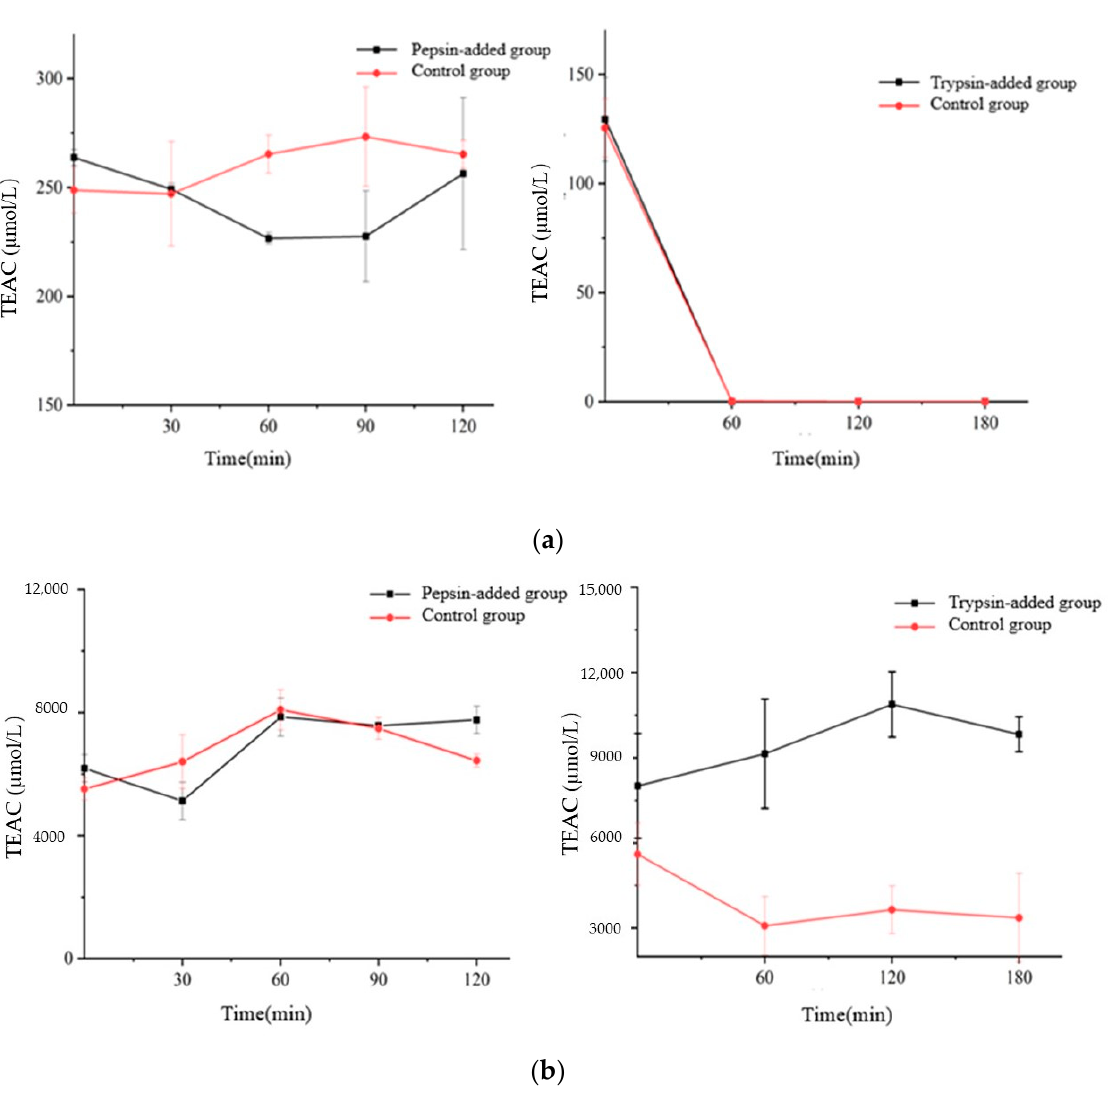
Figure 8. Antioxidant capacity from Semen Hoveniae extracts before and after simulated digestion in vitro. ( a ): DPPH assay. ( b ): ORAC